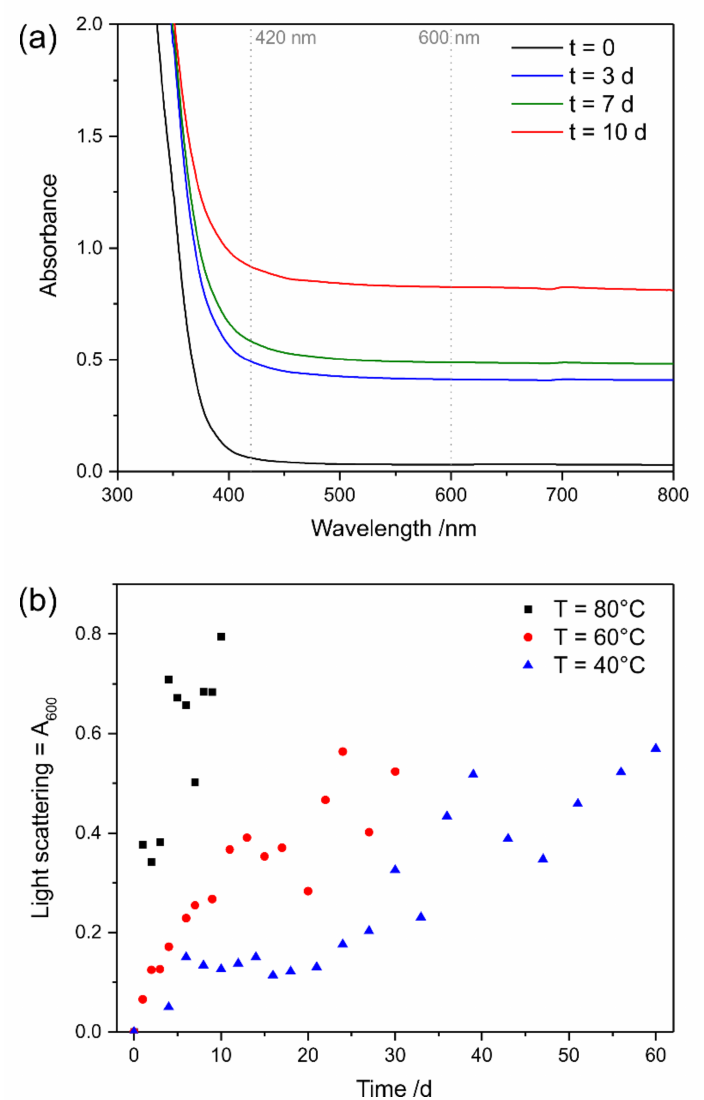
Figure 14. ( a ) UV–Vis spectra of Permount TM after exposure to 80 ◦ C for different numbers of days, and ( b ) development of the light scattering factors over time during exposure of Permount TM to different